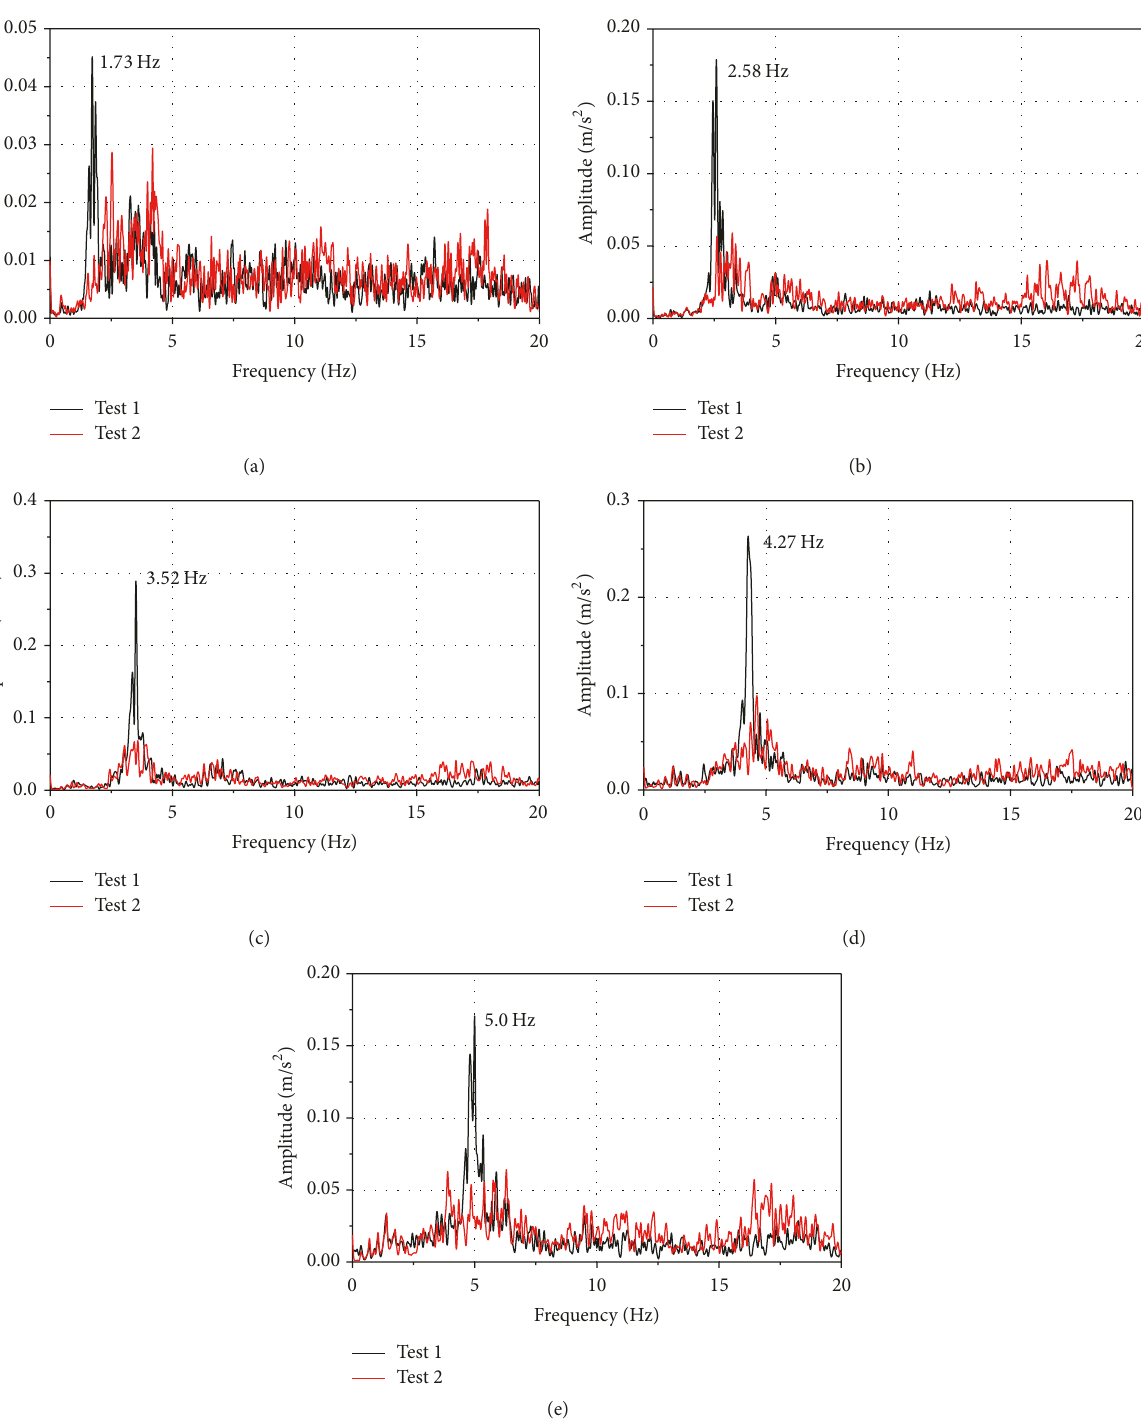
the effects of the track flexibility into account in future work. Meanwhile, the curve passing performance of vehicle with wheel eccentricity should be investigated in future